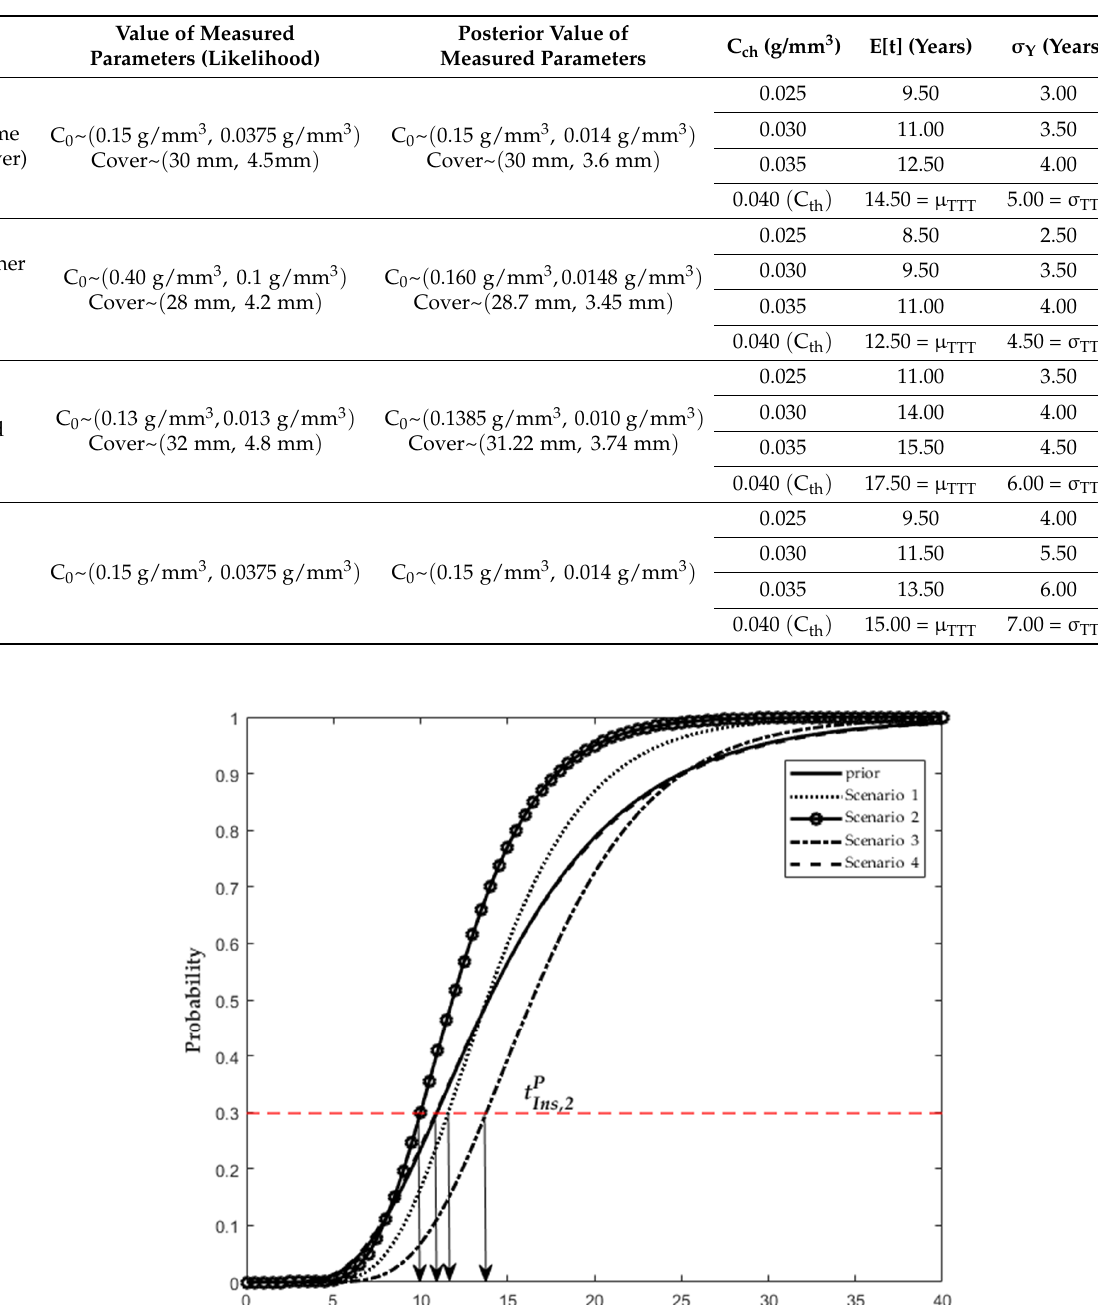
Table 10. Statistical descriptors of the bridge condition and TTT based on the assumed inspection scenarios and poste- rior values.